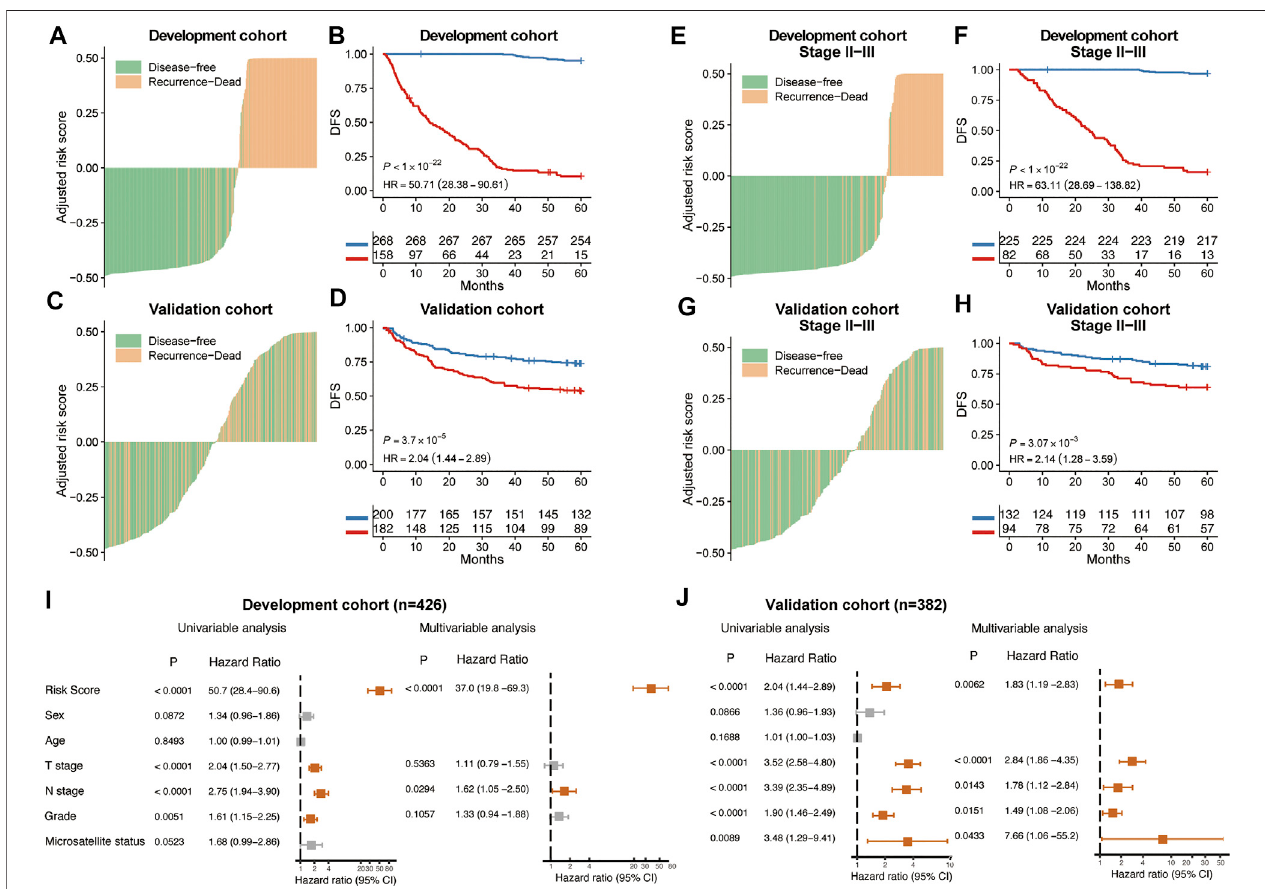
FIGURE2| PrognosticperformanceofMSCNN.ThedistributionofCTsignatureofMSCNNanditscorrespondingrecurrencestatusinthedevelopmentcohort (A) andvalidationcohort (C) .Kaplan-Meiercurvesshowedasigni fi cantsurvivaldifferencebetweenthehighandlowriskgroupsinthedevelopmentcohort (B) andvalidation cohort (D) . Prognostic analysis of CRC patients in stage II and III subgroups (E – H) . Univariable and multivariable analysis of clinical factors in the development cohort (I) and validation cohort (J) .